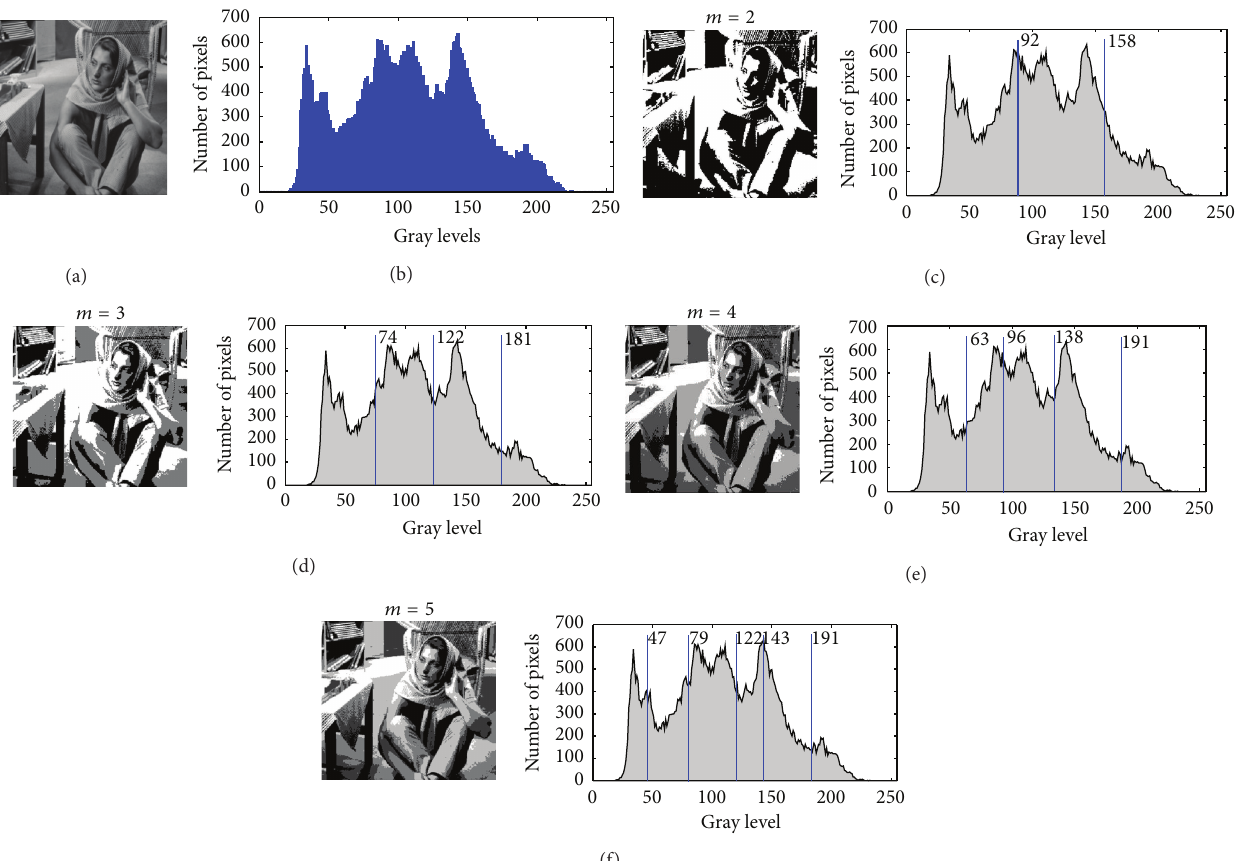
Figure6:(a)OriginalBarbaraimage,(b)histogram,and(c)–(f)segmentedBarbaraimagewithvarious“ 𝑚 ”levelsandcorrespondingoptimal threshold